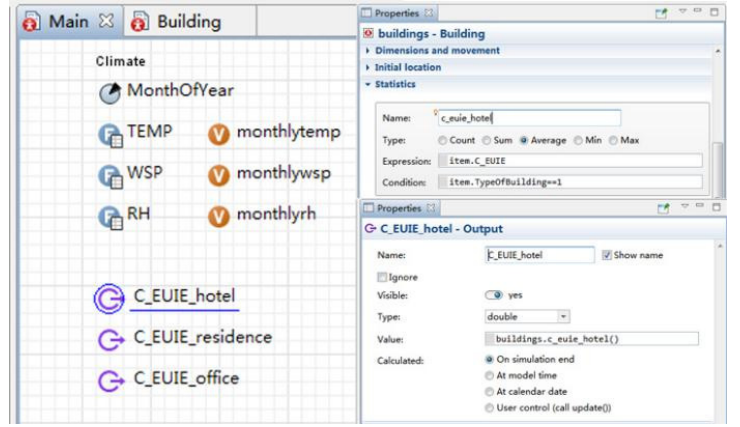
Figure 6. Updated settings of climate module data.